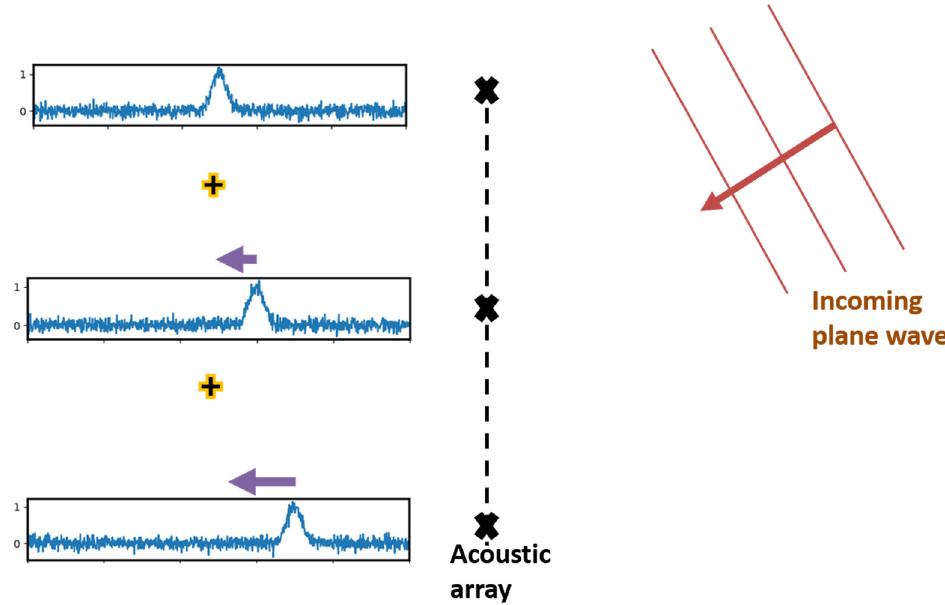
Figure 8. Principle of plane-wave beamforming applied to an acoustic array.